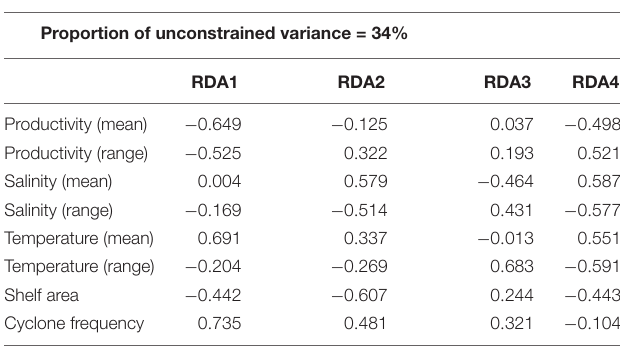
TABLE 5 | Biplot scores for constraining variables derived from the redundancy analysis (RDA) to determine the relative contribution of each environmental variable for the compositional variation of bivalves.